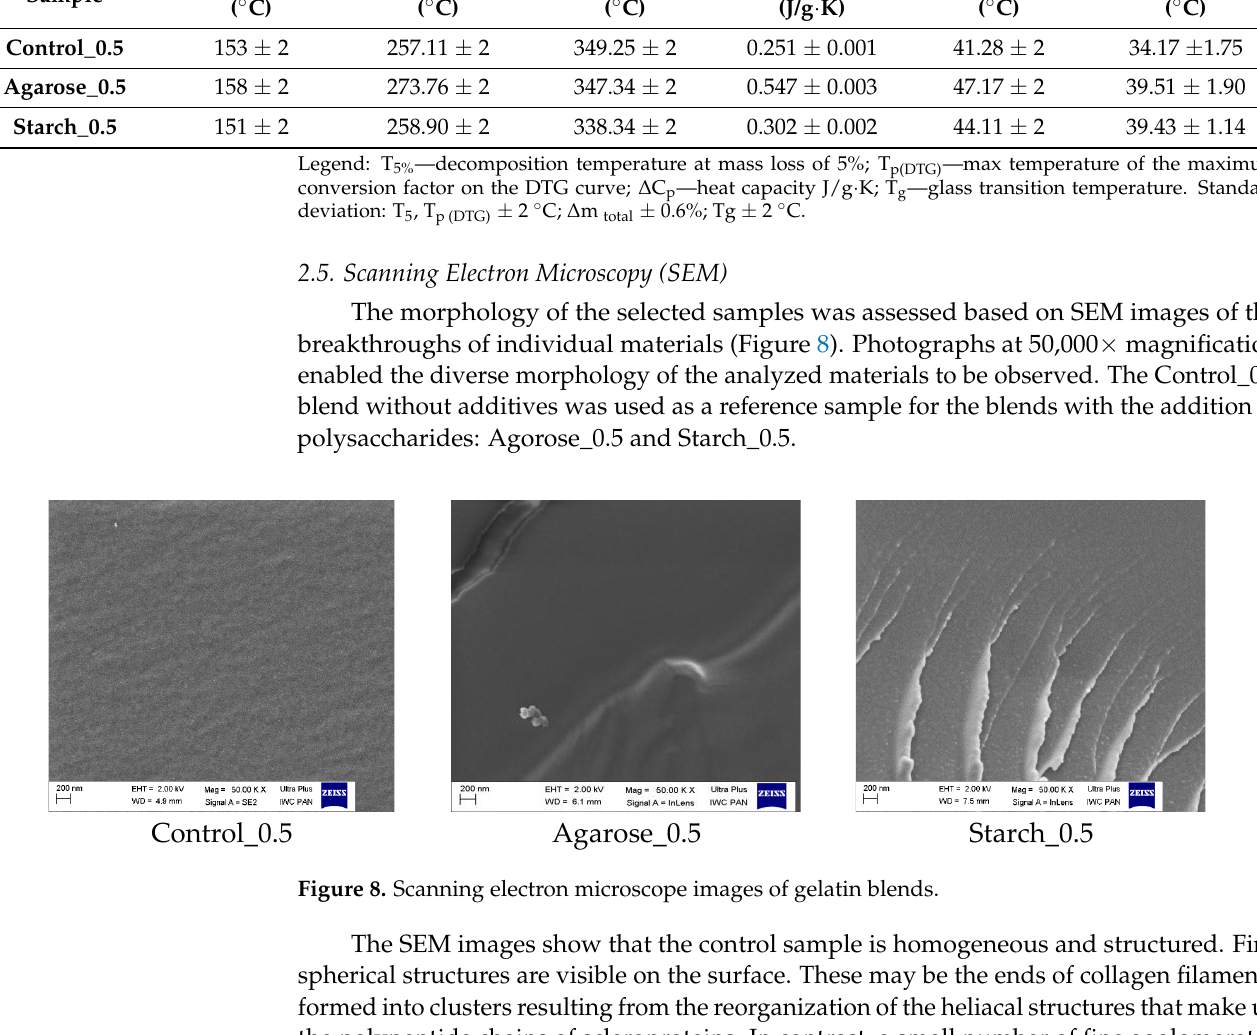
Table 3. Thermal properties of samples.